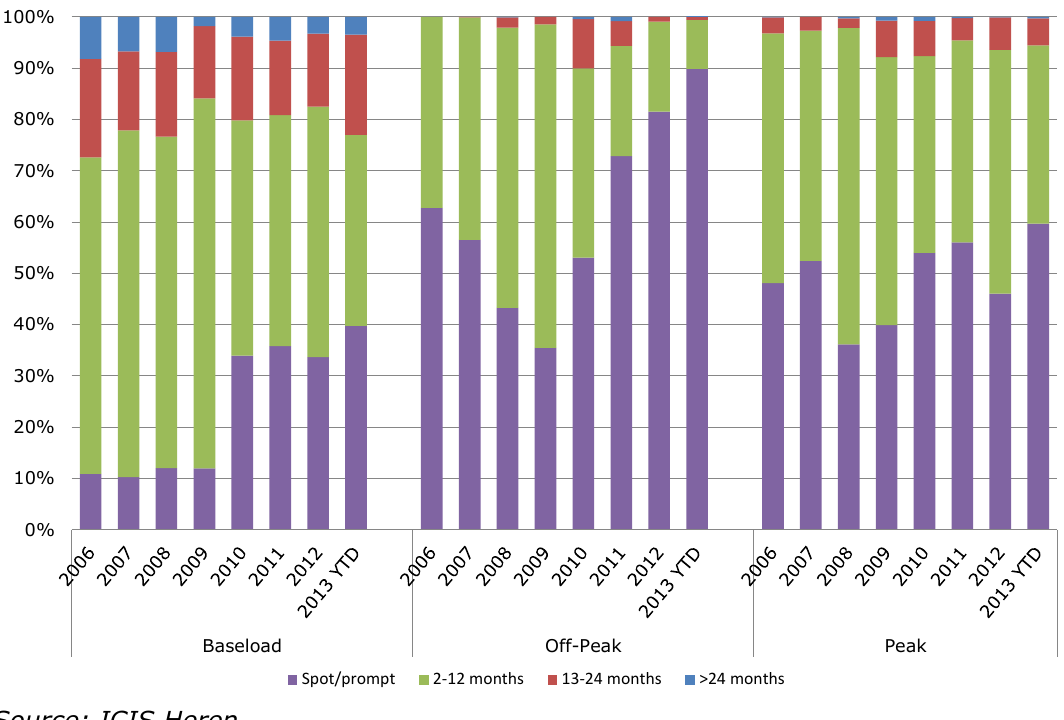
Source: DUKES, ICIS Heren, APX, N2EX, ICE Figure 40: Percentage of volumes traded OTC by period of delivery